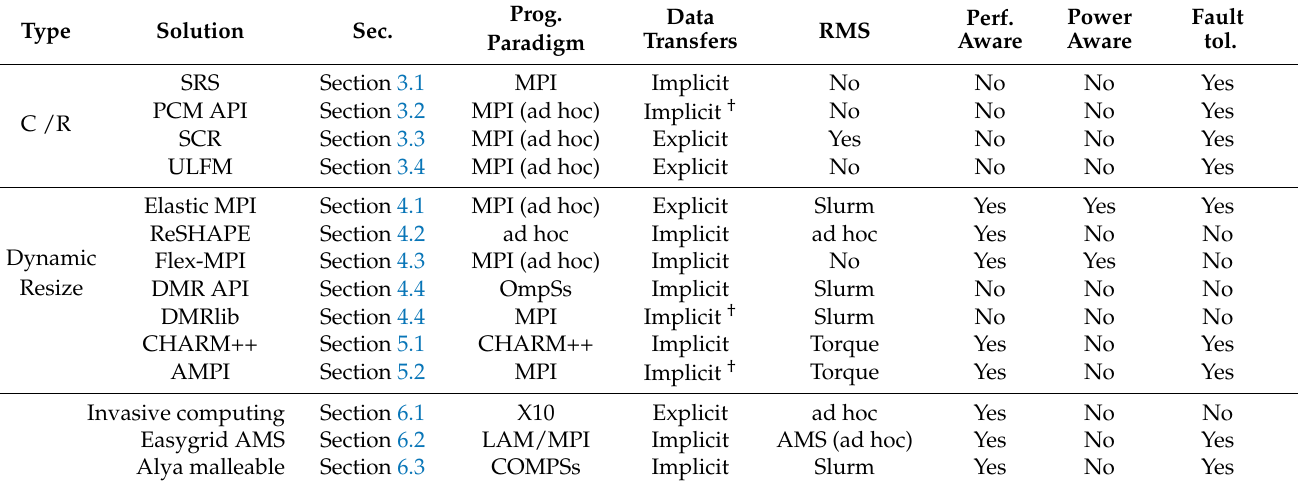
Table 1. Process malleability solution feature